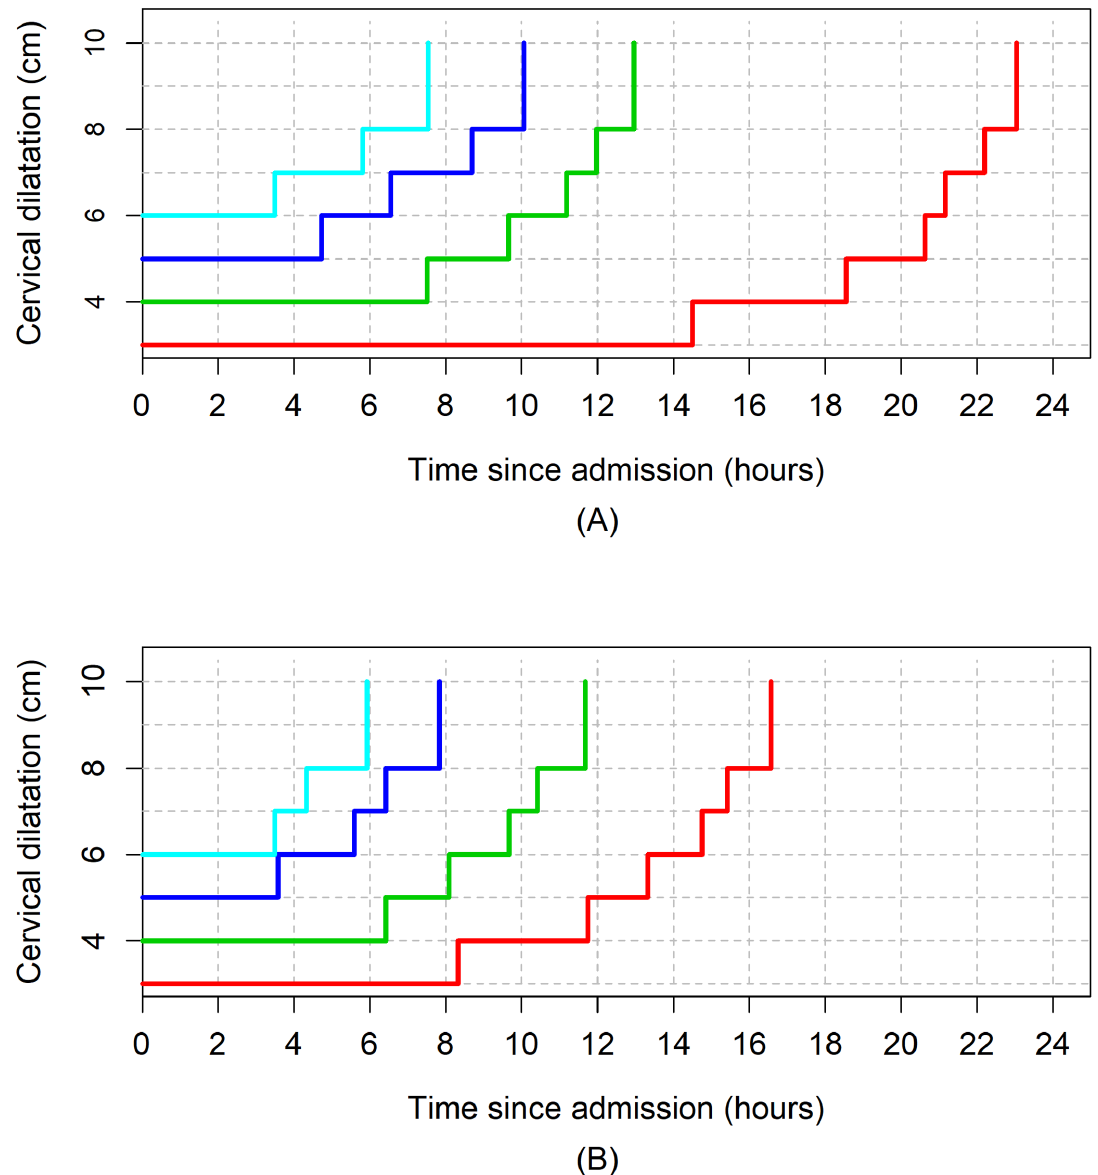
Fig 4. The 95th percentiles of cumulative duration of labour among parity = 1 women. (A) Survival analysis. (B) Multistate Markov analysis.